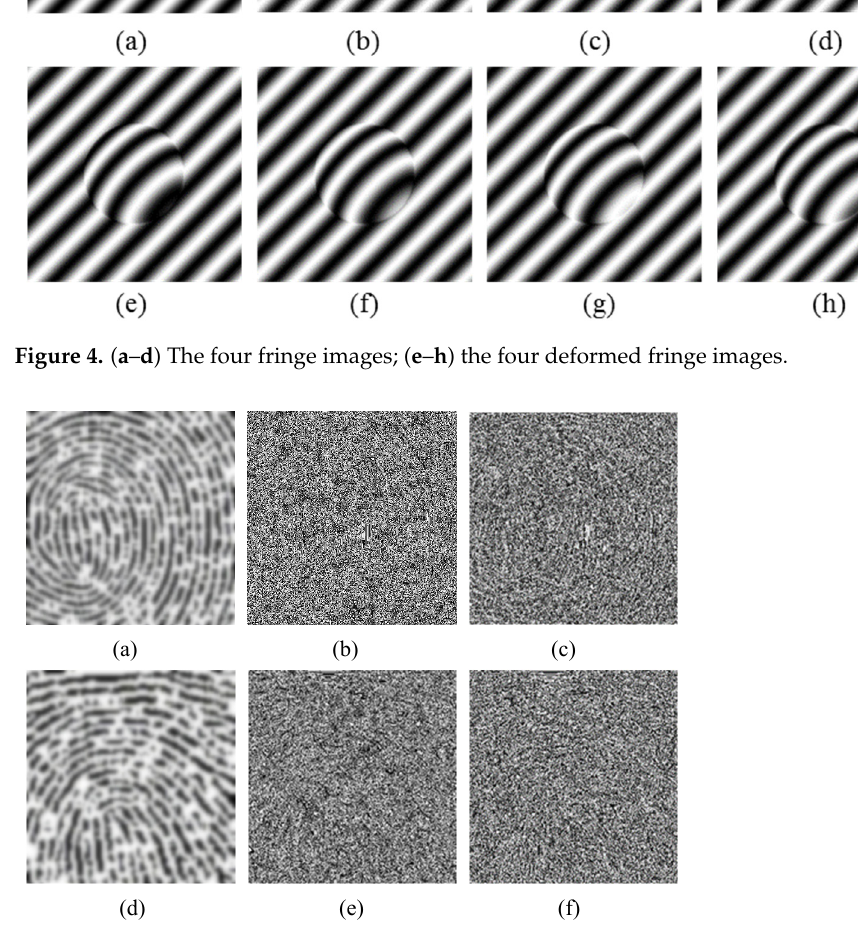
Figure 5. ( a ) Private key of user A; ( b , c ) public keys of user A; ( d ) private key of user B; ( e , f ) public keys of user B.